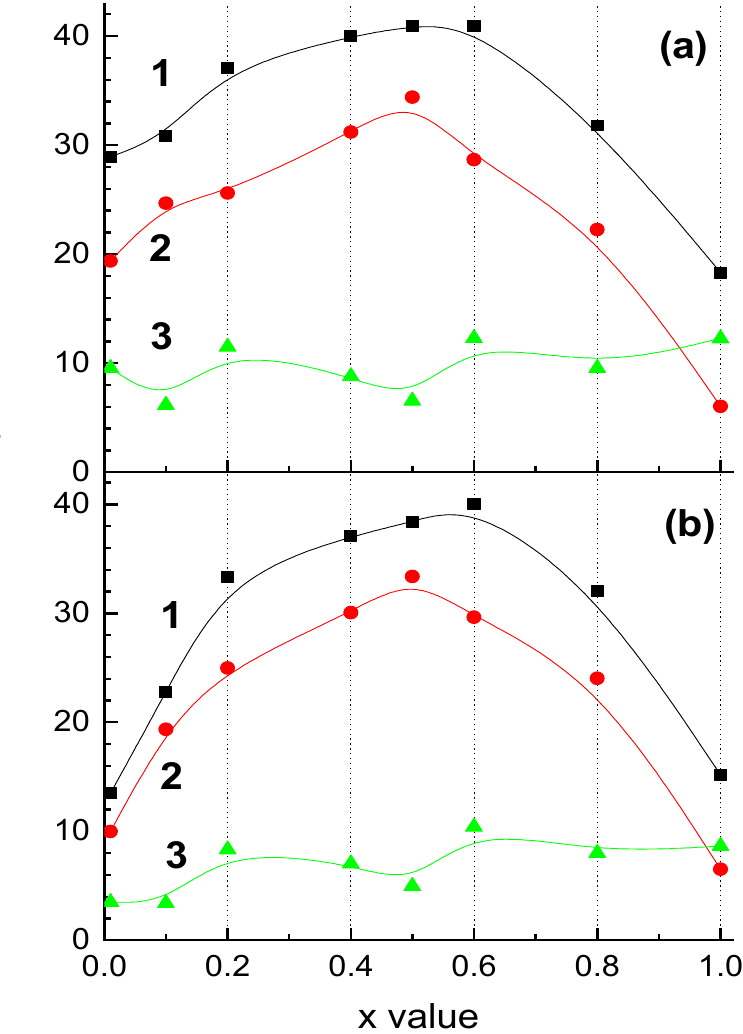
Figure 6. Quantum yield of Y 1 − x Sc x PO 4 solid solutions at E ex = 7.75 eV ( λ ex = 160 nm) ( a ) and E ex = 7.05 eV ( λ ex = 176 nm) ( b ), T = 300 K. The signal was integrated over 200–700 nm spectral region (curve 1) as well as in the region of the UV-C (2) and blue (3) emission bands.